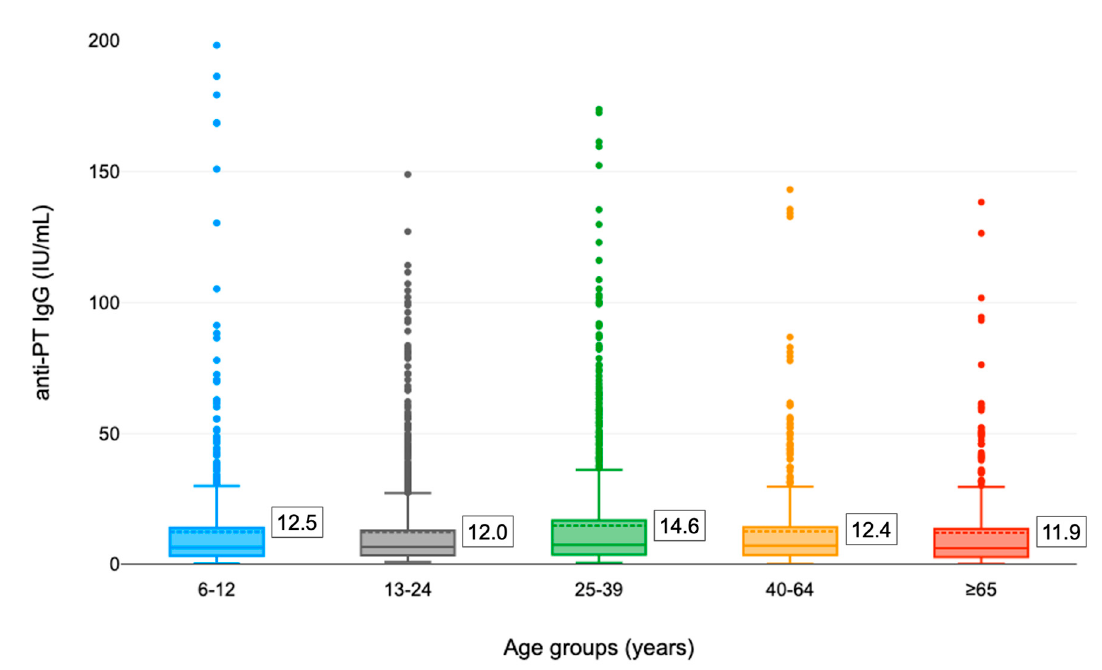
Figure 2. Distribution of anti-PTx IgG titers in different age groups (the mean concentration is shown in the box).